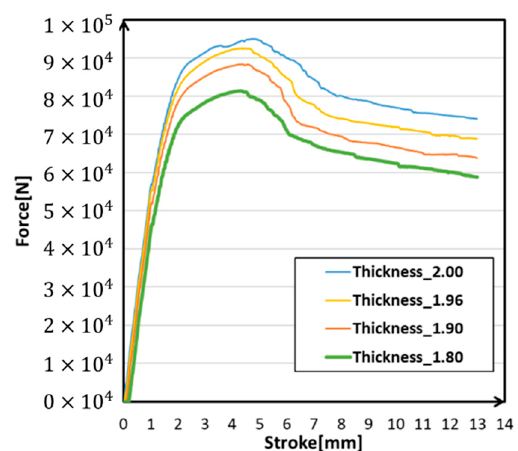
Figure 14. Force-stroke curves under different wall thickness.